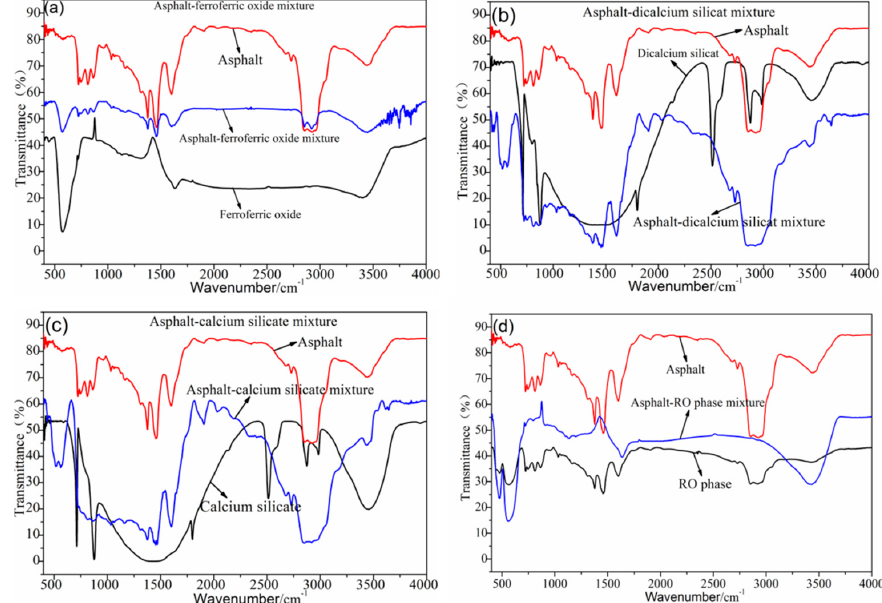
Figure 4. FTIR test results of the steel slag mineral composition–asphalt mixture. ( a ) FTIR test results of Asphalt-ferroferric oxide mixture, ( b ) FTIR test results of Asphalt-dicalcium silicate mixture, ( c ) FTIR test results of Asphalt-calcium silicate mixture, ( d ) FTIR test results of Asphalt-RO phase mixture.